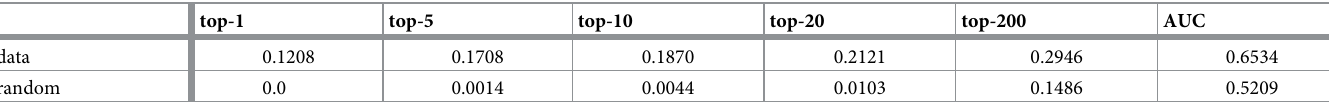
Table 3. Top- n accuracy, and AUC, of IOKR on MIBiG data.